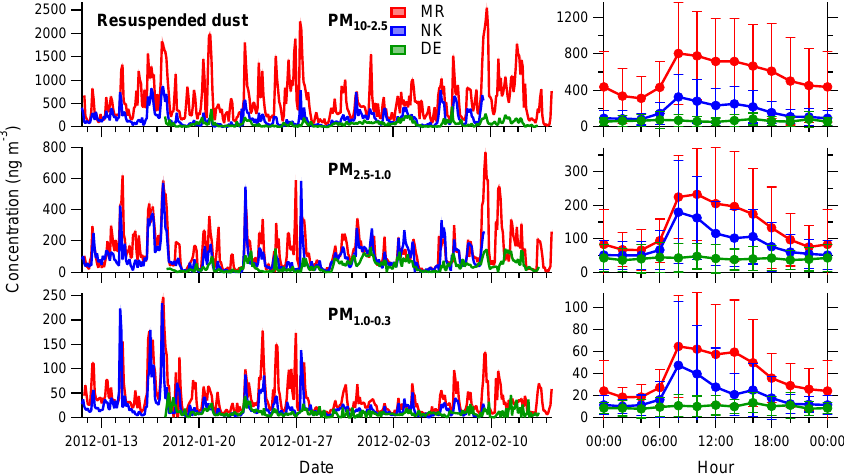
Figure 7. Time series (left) and diurnal variations (right) of the resuspended dust factor at MR, NK and DE for PM 10–2 . 5 , PM 2 . 5–1 . 0 and PM 1 . 0–0 . 3 . Time series show the mean of all good solutions ± 1 SD as shaded areas. Diurnals show the mean of the time series ± 1SD as whiskers, with the hour being the start of a 2h sampling period (00:00UTC means sampling from 00:00 to 02:00UTC).